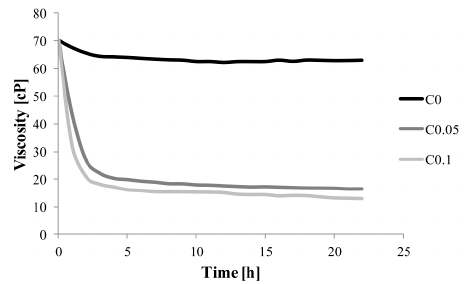
Figure 1. The effect of time (22 h) on viscosity of chitosan/hydroxypropyl methylcellulose hydrosols during enzymatic degradation by cellulase (C) in addition of 0%, 0.05% and 0.1% (C0, C0.05 and C0.1).